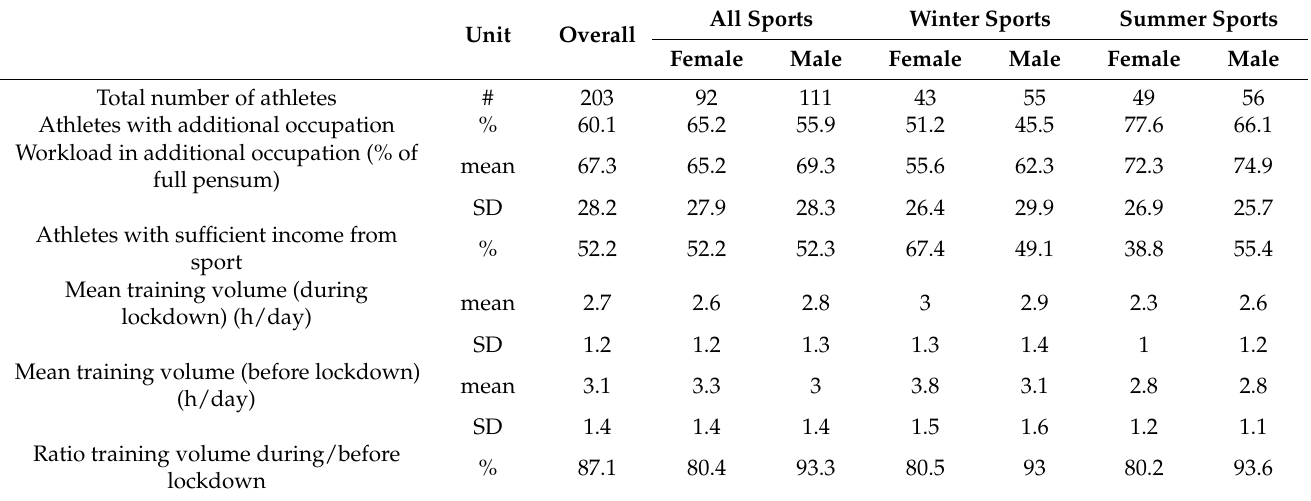
Table 1. Baseline